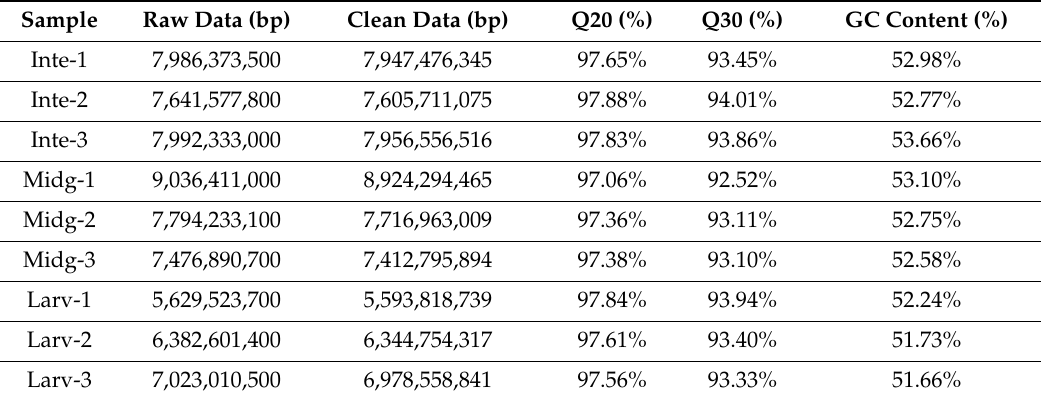
Table 1. Summary statistics of G. pyloalis genes based on RNA-seq